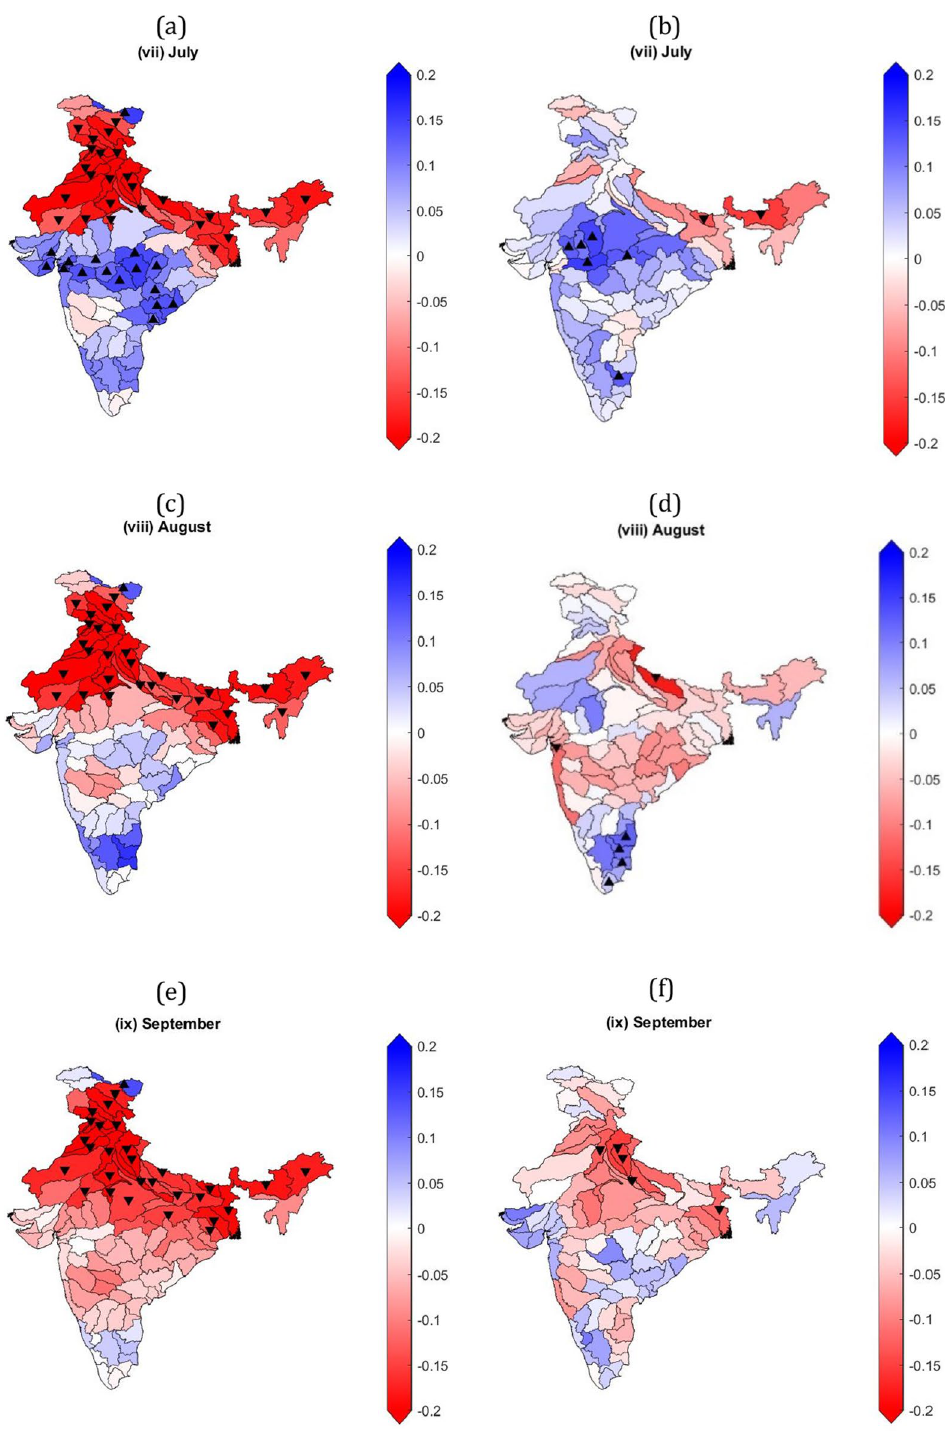
Figure 4. Monthly GRACE-DSI/CCDI trends using the Mann Kendall trend test and Theil-Sen’s slope estimator over major Indian river basins for July, August, and September months. ( a ) GRACE-DSI trends for July month, ( b ) CCDI trends for July month, ( c ) GRACE-DSI trends for August month, ( d ) CCDI trends for August month, ( e ) GRACE-DSI trends for September month, ( f ) CCDI trends for September month. Colormap over the basin represents the slope obtained from TSA, △ represents a significant increasing trend, and ▽ indicates a significant decreasing trend based on the Mann–Kendall